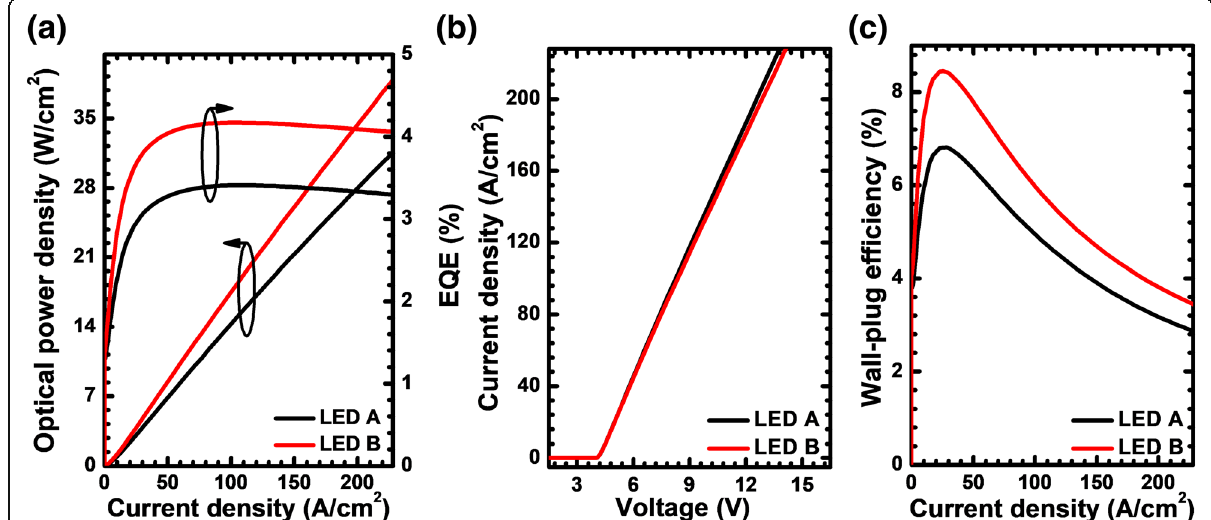
Fig. 5 a Optical output power density and EQE as a function of the injection current, b current-voltage characteristic, c WPE in terms of the injection current for LEDs A and B, respectively